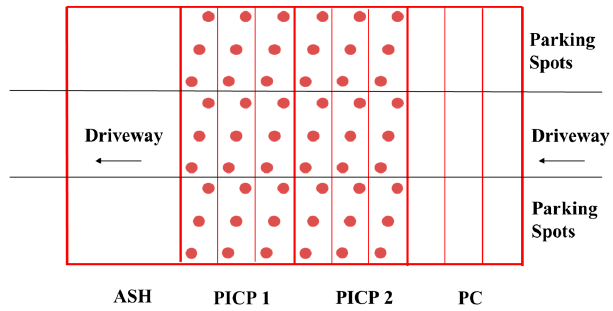
Figure 4. Infiltration testing scheme at permeable interlocking concrete pavement (PICP) 1 and PICP 2.